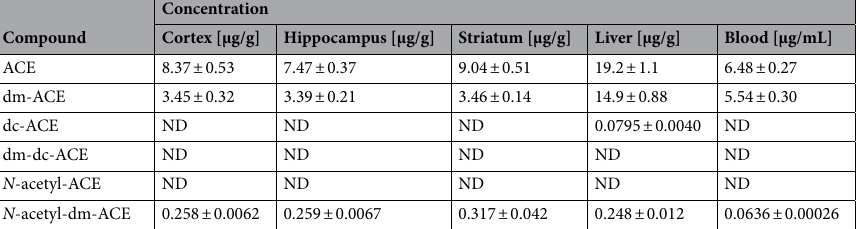
C.C. of the neuronal population were measured (Table 3). The amplitude of Ca 2+ transients had significantly decreased in the high-AUC cell group, 30 min and 2 h